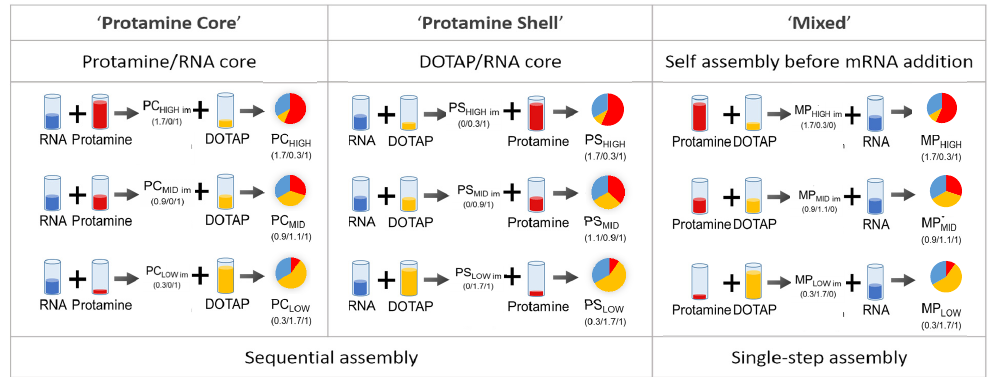
Figure 1. Graphical representation of the concept of di ff erent assembly routes for the preparation of hybrid particles. Three di ff erent particle topologies with protamine as either the first added component (PC), the last added component (PS), or in a mixture with DOTAP before RNA addition (MP) were compared. The N / P ratio composition is given underneath the pie charts (protamine / DOTAP / mRNA).